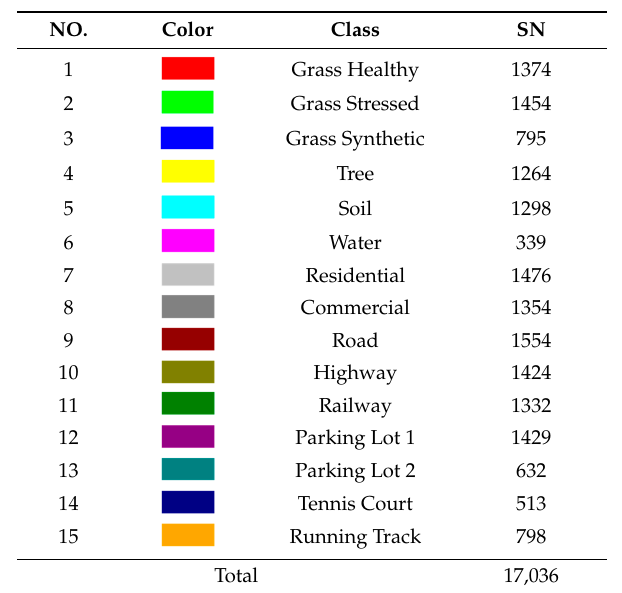
Table 2. Color codes for the classes, class types, and sample numbers (SN) for the ground truths of the Indiana Pines (IP) data, Kennedy Space Center (KSC) data, and Salinas Scene (SS) data.